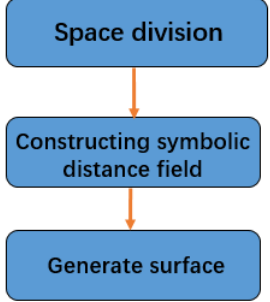
Figure 6. The flow chart of surface reconstruction. The flow chart of the texture-creation algorithm is shown in Figure 7.